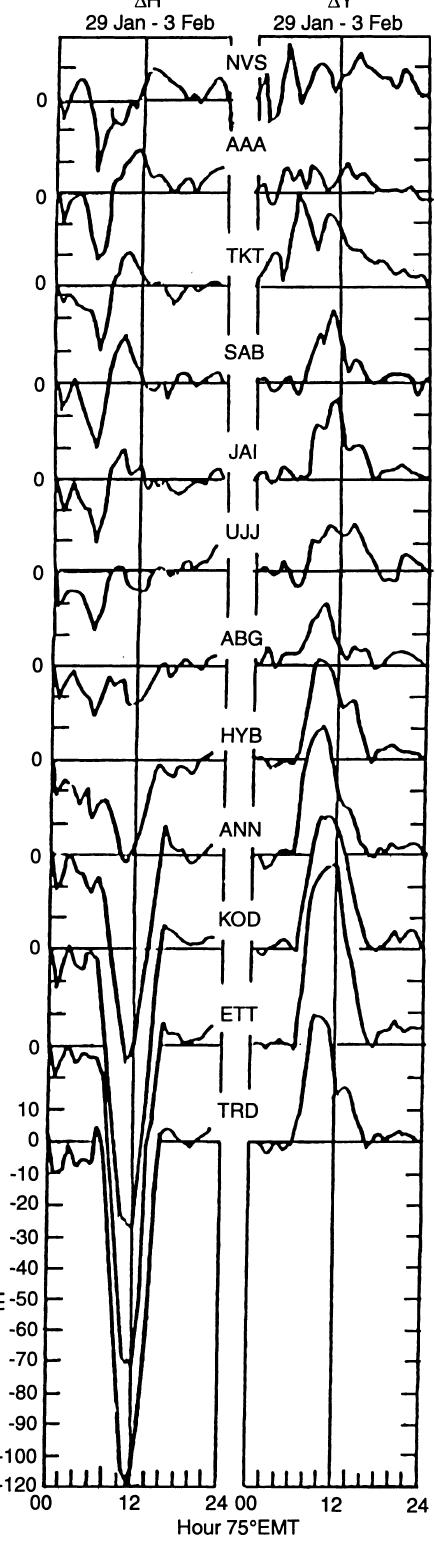
Fig. 7. The daily variations of D H and D Y at each of the stations on 29 January, 1987 and on 3